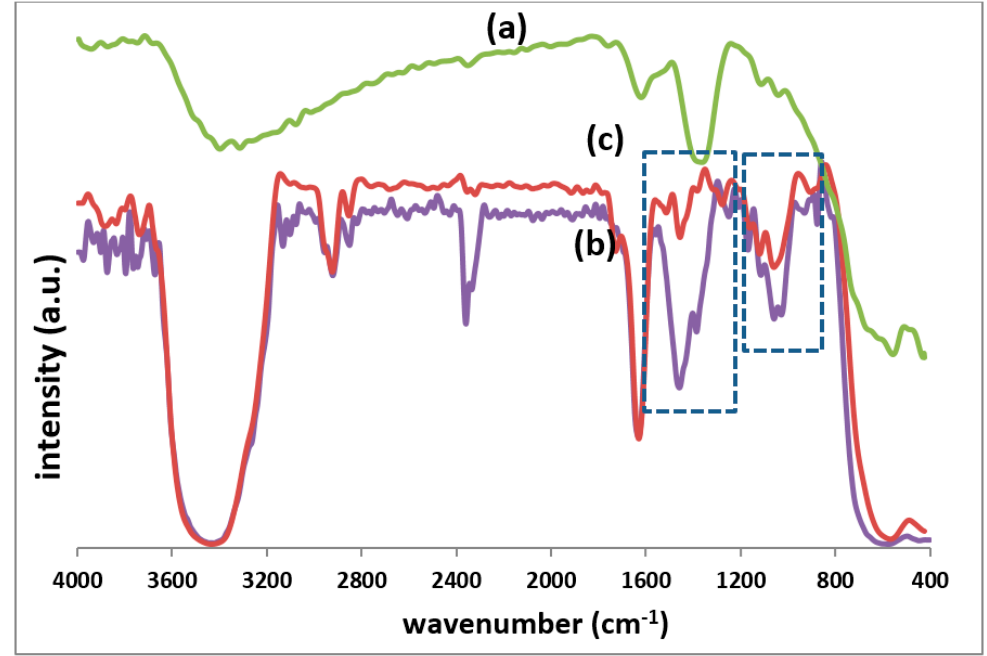
Figure 4. FTIR spectra of the fabricated: ( a ) bare MNPs; ( b ) PEG-MNPs; and ( c ) Co-doped PEG-MNPs.